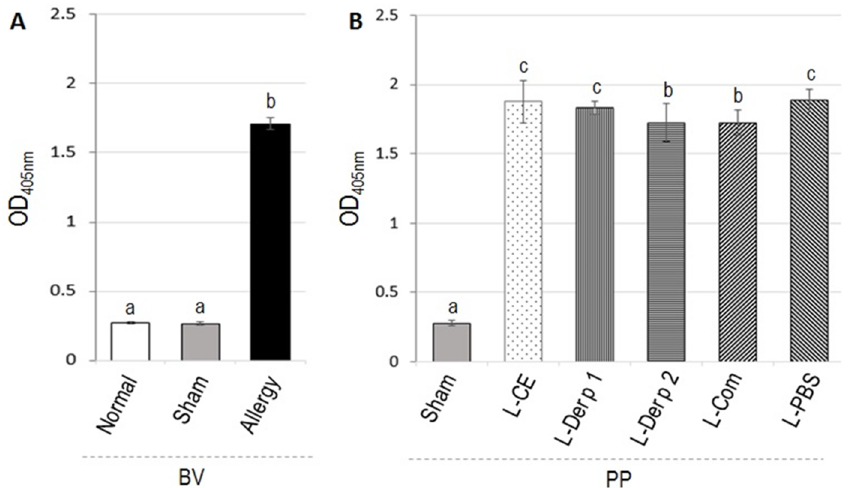
Fig 2. Indirect ELISA OD 405nm (means ± SD) of Dp-CE-specific IgG1 in sera of allergenized mice compared to sham and normal mice (A) before receiving vaccines/placebo (BV) and (B) Dp-CE- specific IgG1 in sera of allergic mice after treatment with the vaccinesand provoked with aerosolic Dp-CE compared with placebo and sham mice (PP). Bars with different superscripts of BV or PP were different at p (cid:20) 0.05.